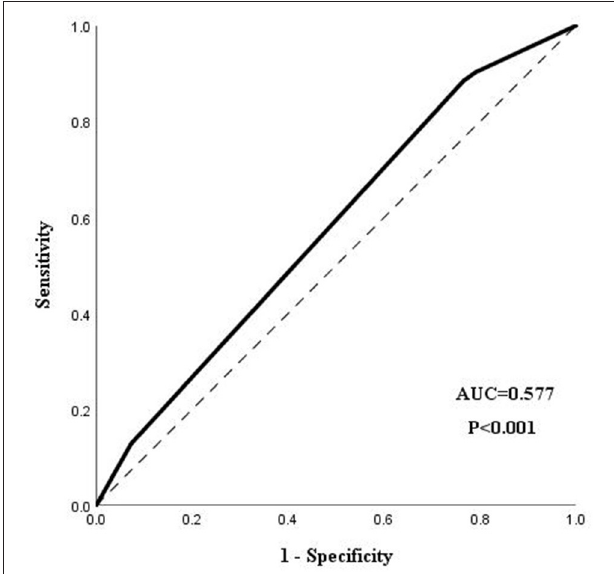
FIGURE 1 | The ROC analysis of the regression